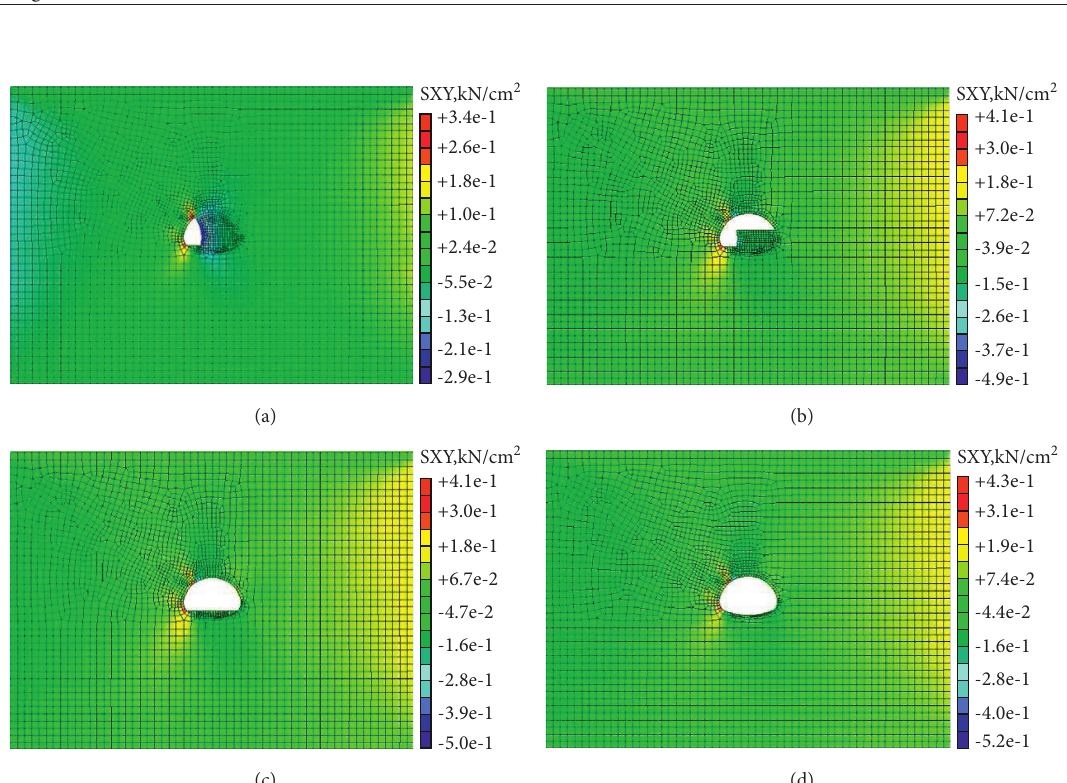
Figure 4: Small pilot tunnel first and step reverse expansion excavation. (a) Completion of the left pilot tunnel. (b) Completion of the upstairs. (c) Completion of the middle step. (d) All construction is completed.